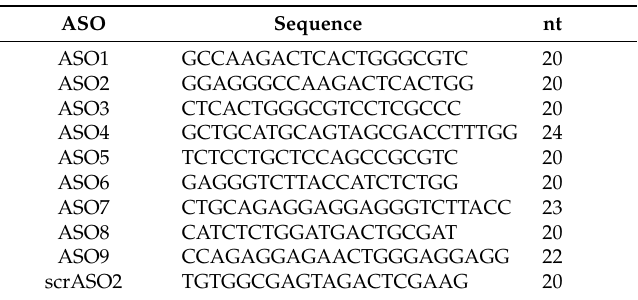
Table 4. Rationally designed